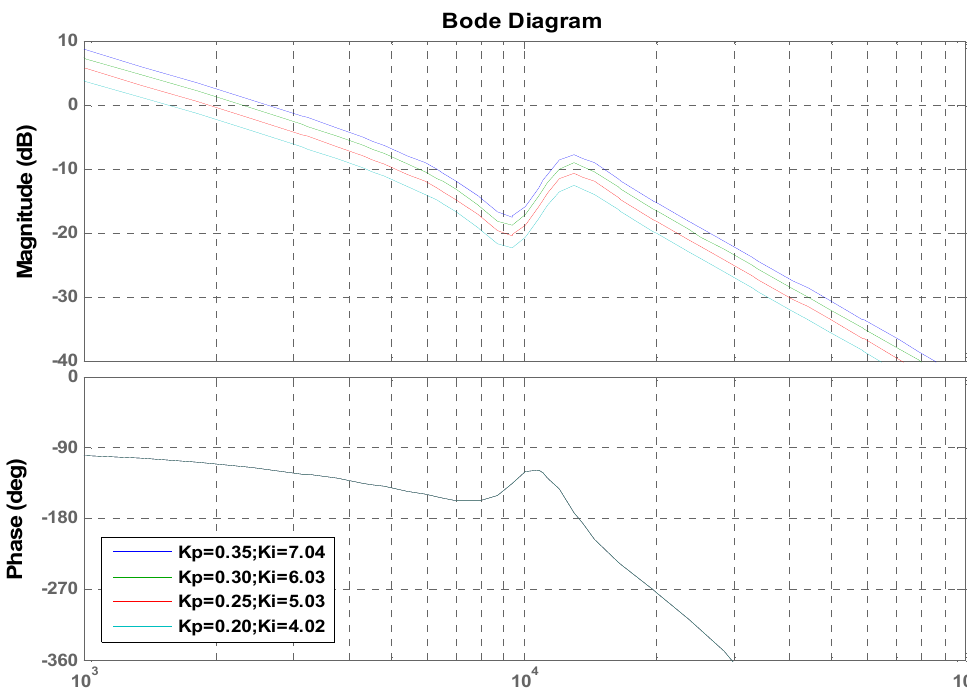
Figure 17. Bode diagram of current control loop of